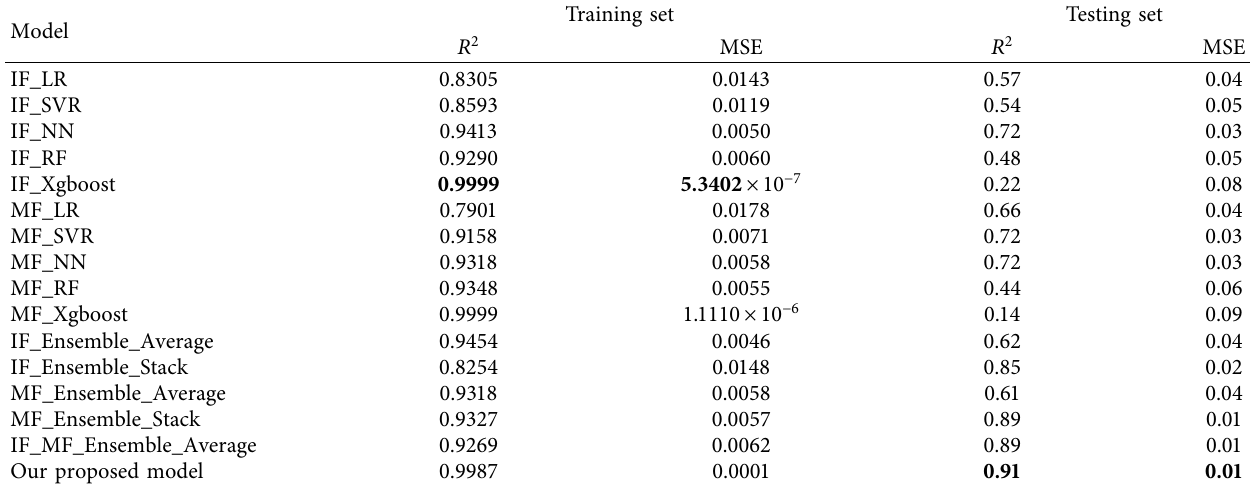
Table 5: Prediction model